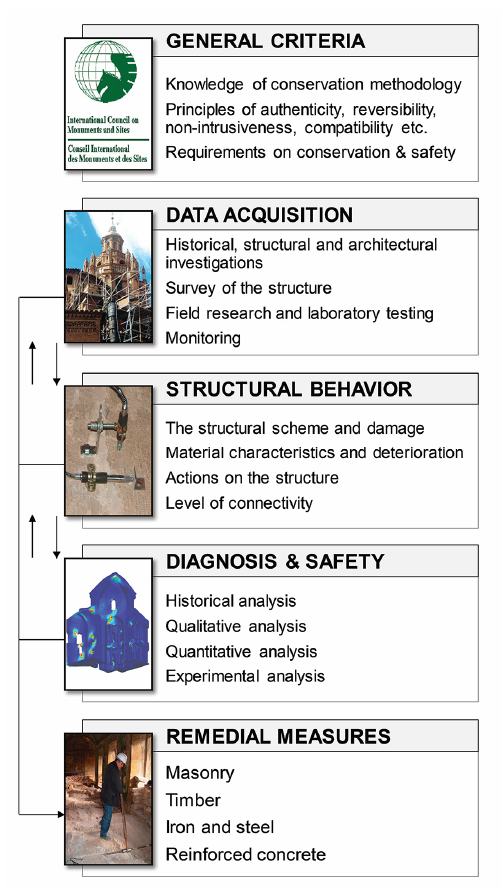
Figure 2. The ICOMOS methodology, adapted from [5].